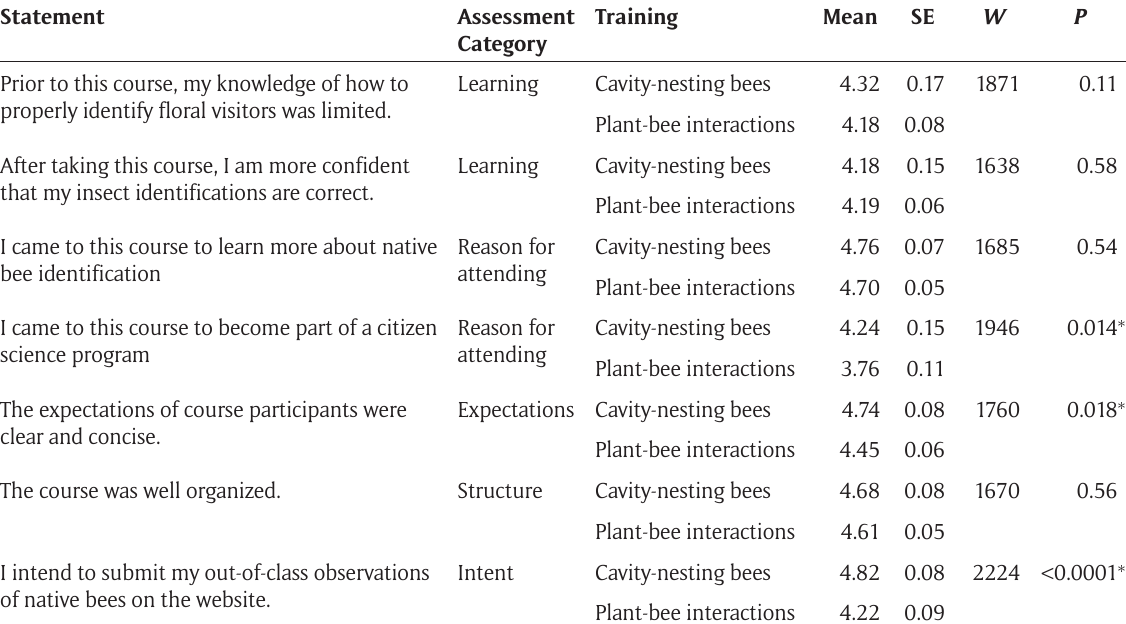
Figure 4: Factors affecting the frequency of data submission. (a) The percentage of trainees, and the percentage that submitted data, for each project. (b) The percentage of trainees across different educational attainments that submitted data across the two projects. Table 2: Results of Wilcoxon rank sum tests comparing differences of Likert-scale response to each question between the two citizen science trainings. P values below α = 0.05 (shown with an asterisk) indicate a significant difference in responses across the